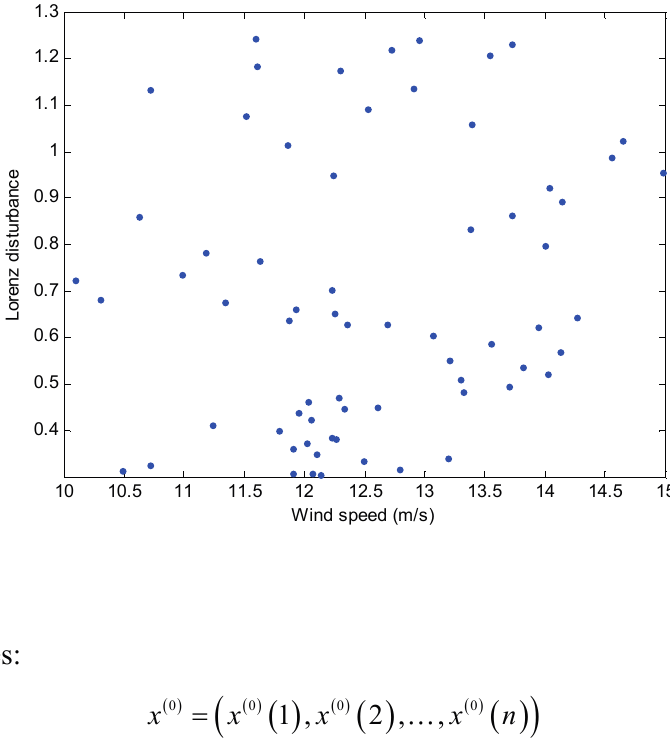
Figure 2. Wind speed versus the corresponding disturbance series for a period of